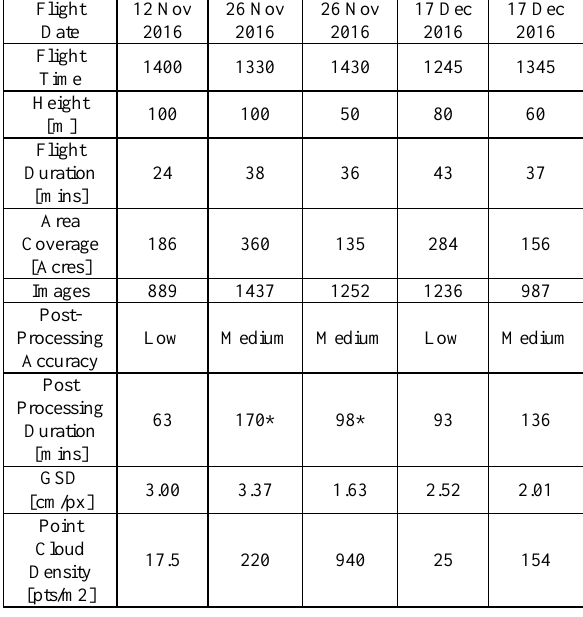
Table 1. Flights and post-processing details (*without orthomosaic creation)